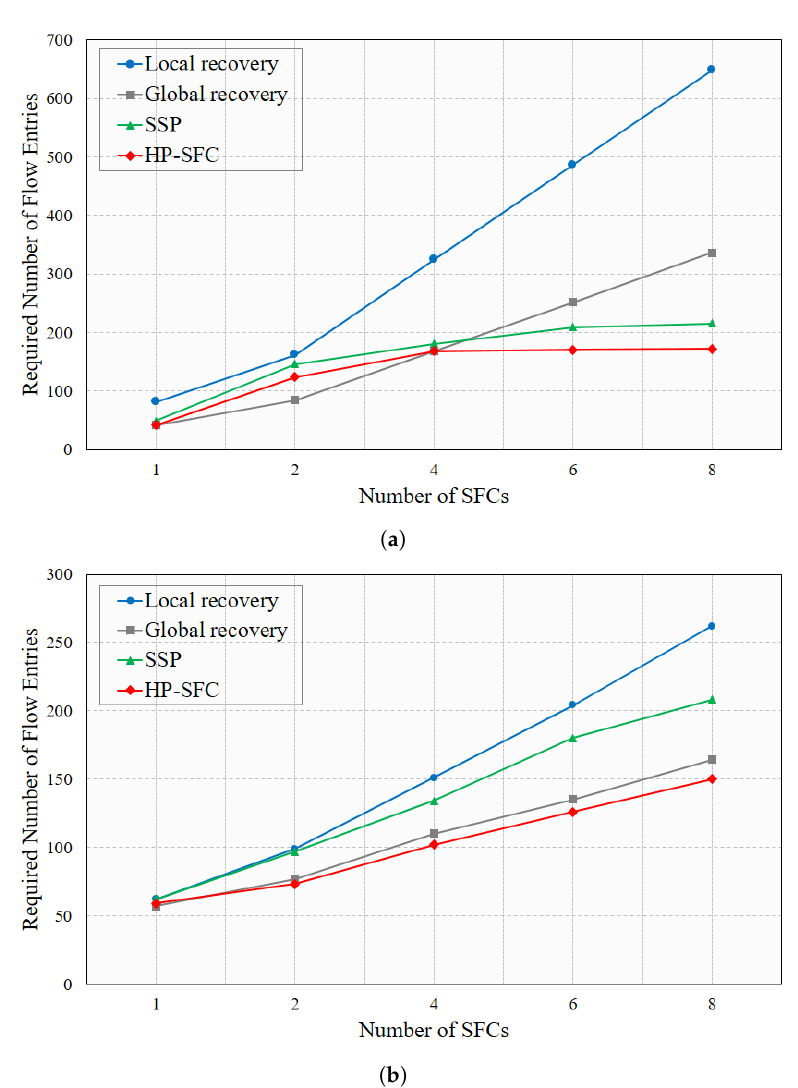
Figure 6. Flow table resource utilization comparison of local recovery, global recovery, SSP, and HP- SFC in the data center and enterprise topologies. ( a ) Flow table resources utilized in the data center topology by backup paths. ( b ) Flow table resources utilized in the enterprise topology by backup paths.